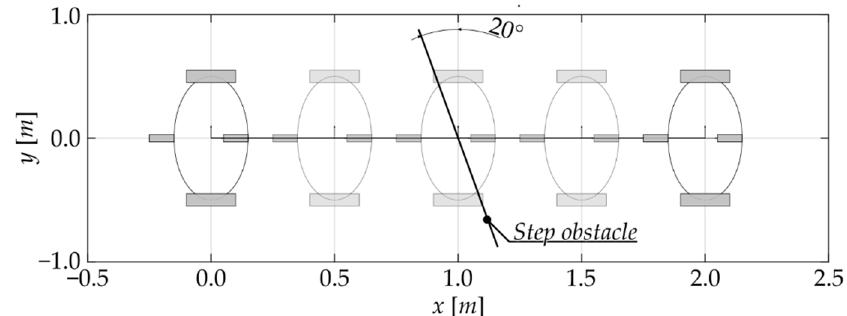
Figure 8. Use case simulation 2: straight path with a step obstacle.